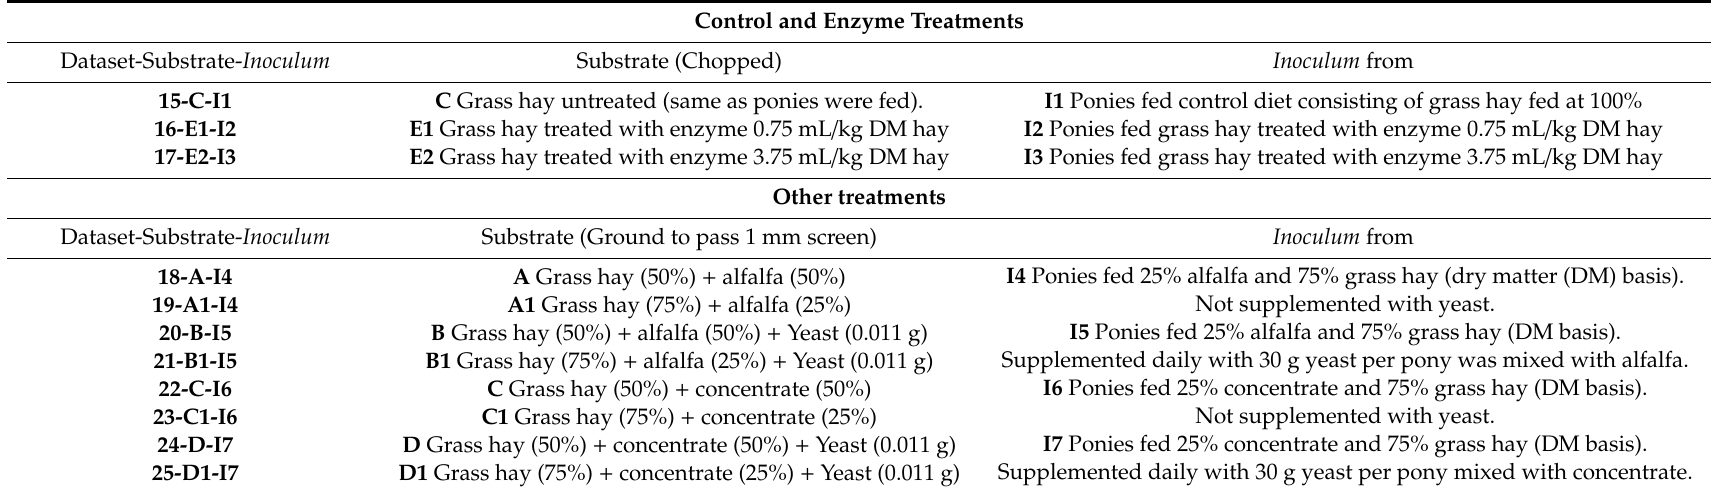
Table 1. Details of the eleven treatments used in Experiment